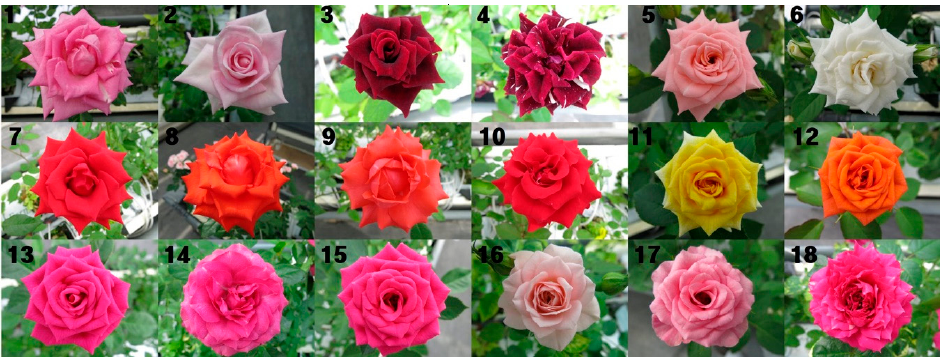
Figure 1. Profile of rose mutant genotypes used in this study. 1 : Aqua, 2 : CR-S7 (Aqua